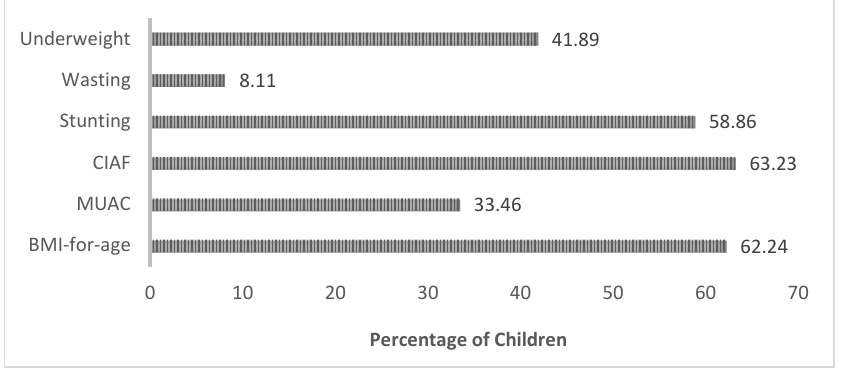
Figure 5. Malnutrition prevalence according to BMI-for-age, MUAC, CIAF, and Conventional An- thropometric Indices (Stunting, Wasting, and Underweight).